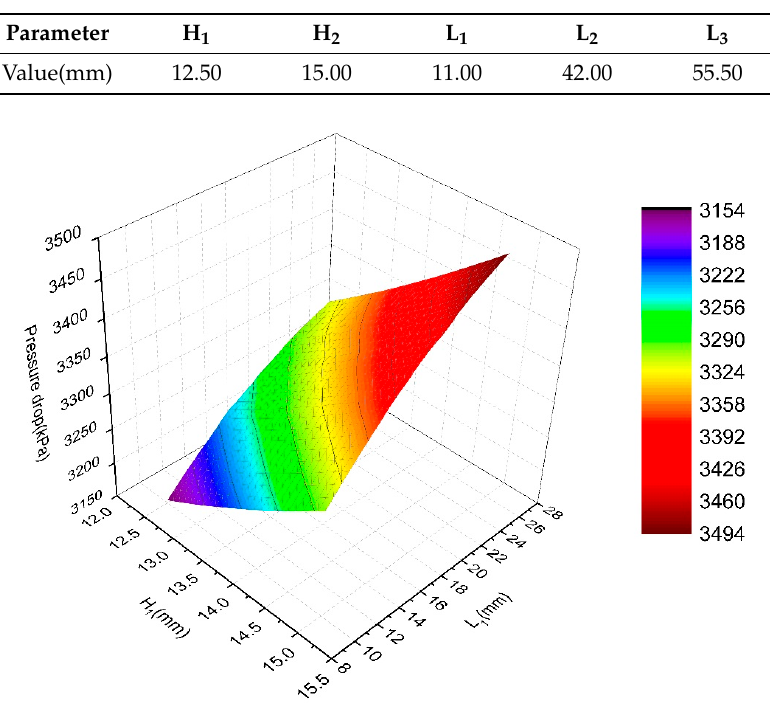
Table 9. Candidate points.